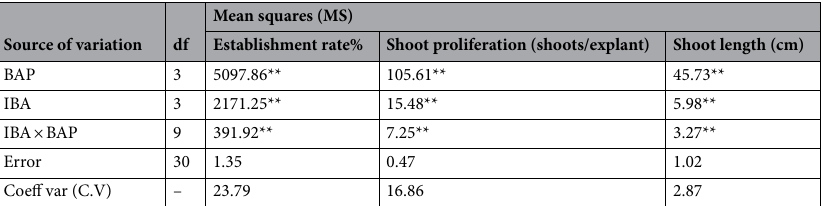
Mean squares (MS)